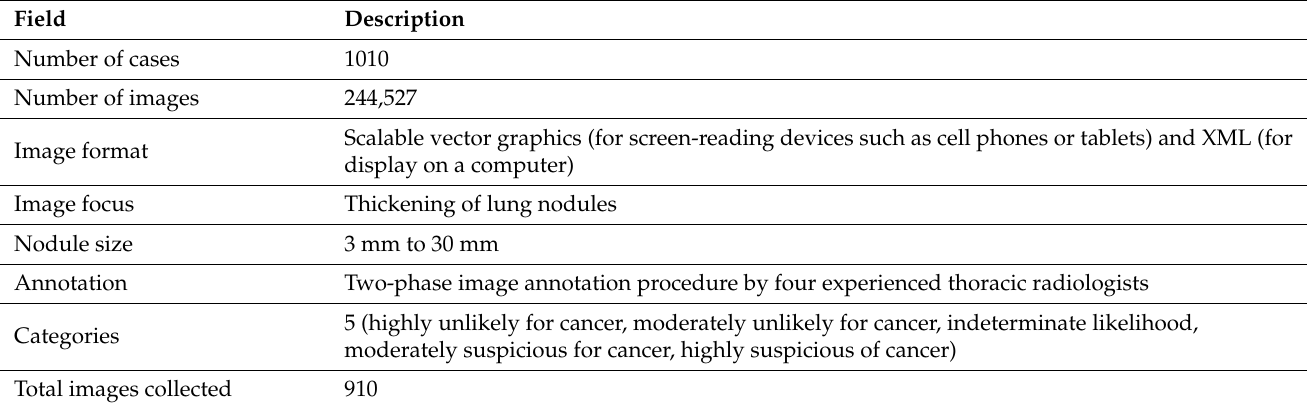
Table 2. Characteristics and Features of the LIDC-IDRI Dataset for Lung Cancer Detection and